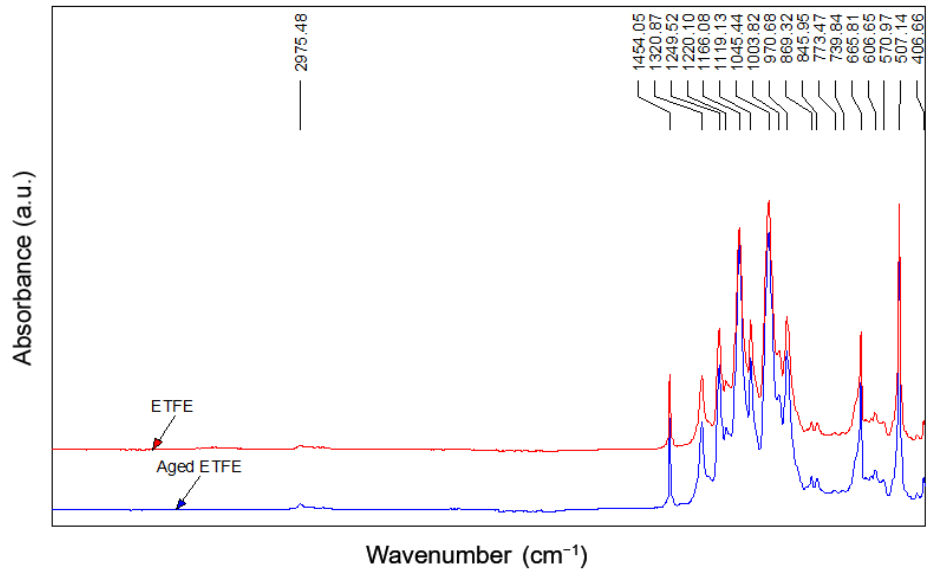
Figure 12. FTIR spectra of ETFE films before and after aging.